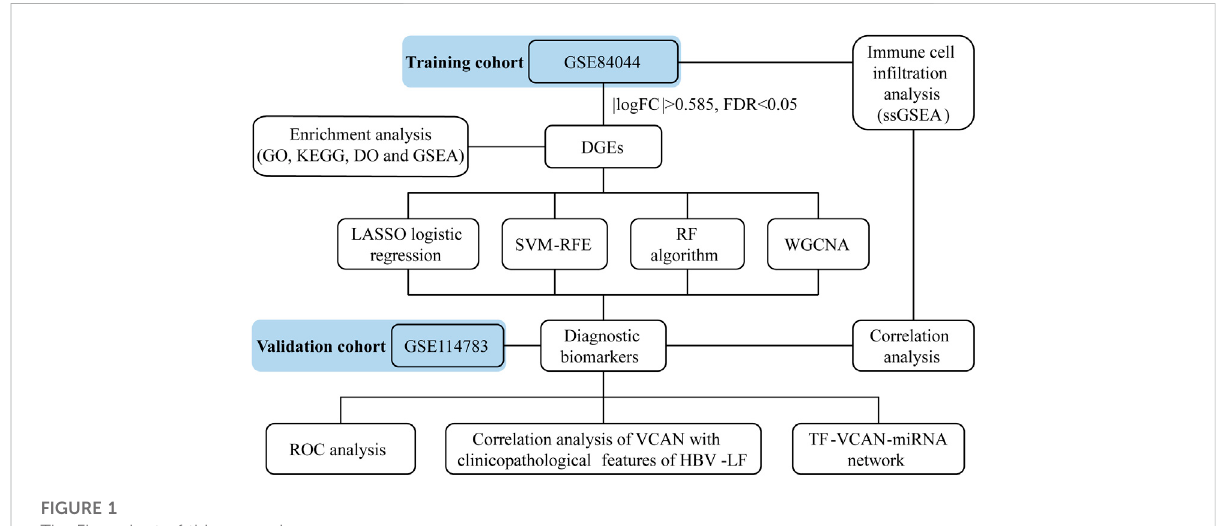
FIGURE 1 The Flow chart of this